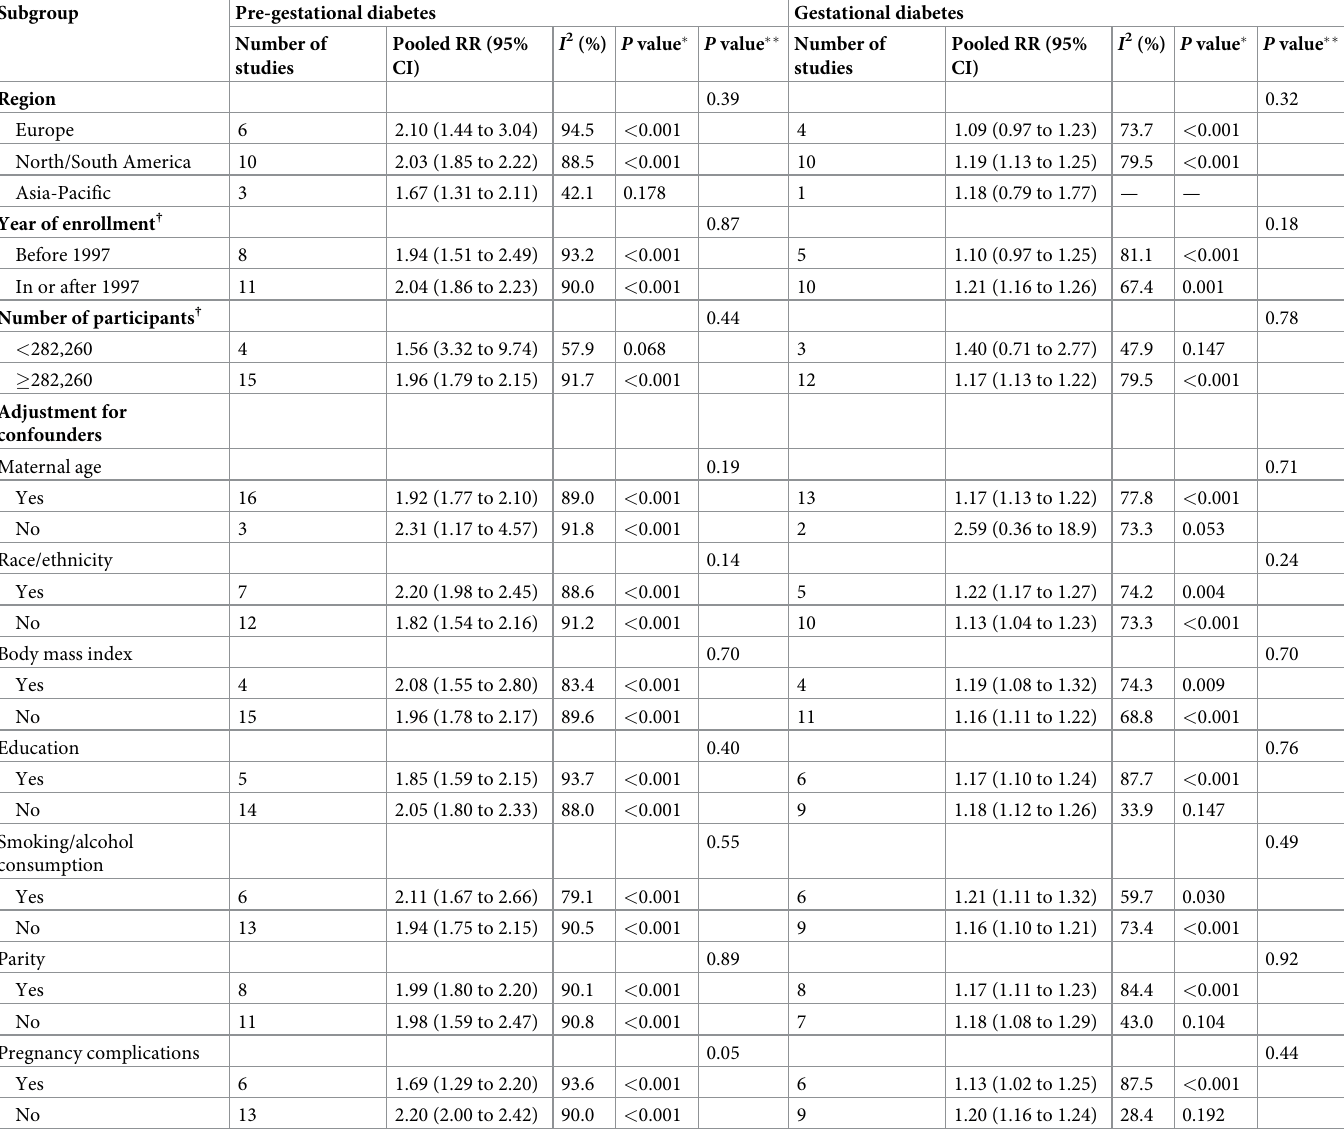
Table 4. Subgroup analysis of the association between maternal diabetes and risk of overall congenital anomalies in offspring: Results of meta-analyses.